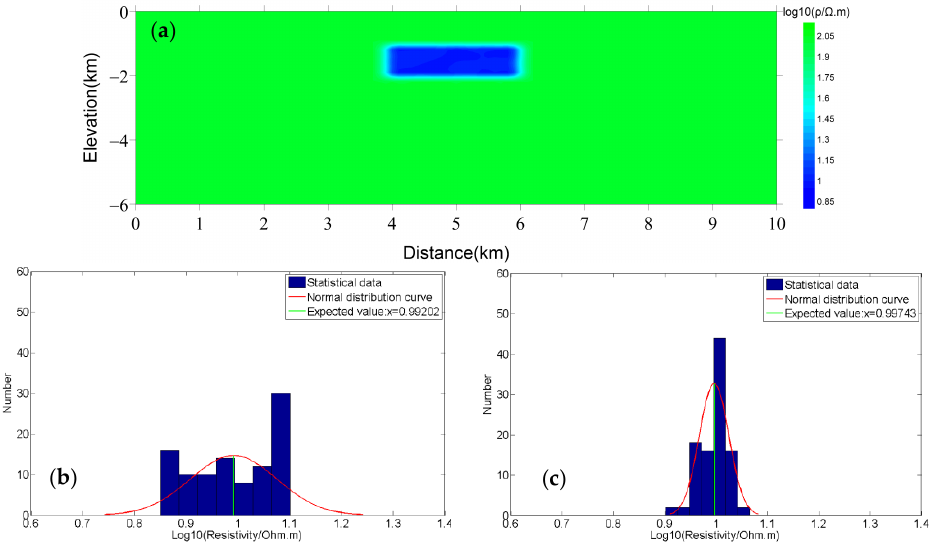
Figure 8. The misfit curve of 2D TM-mode inversion.